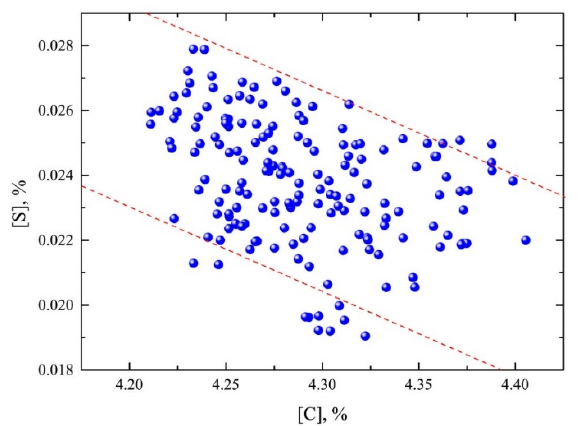
Figure 10. Comparisons between carbon and sulfur contents of tapped hot metal from the blast furnace.